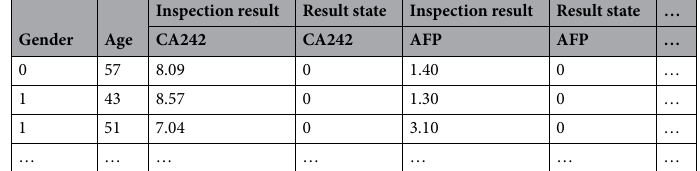
Table 2. Sample of the preprocessed dataset.